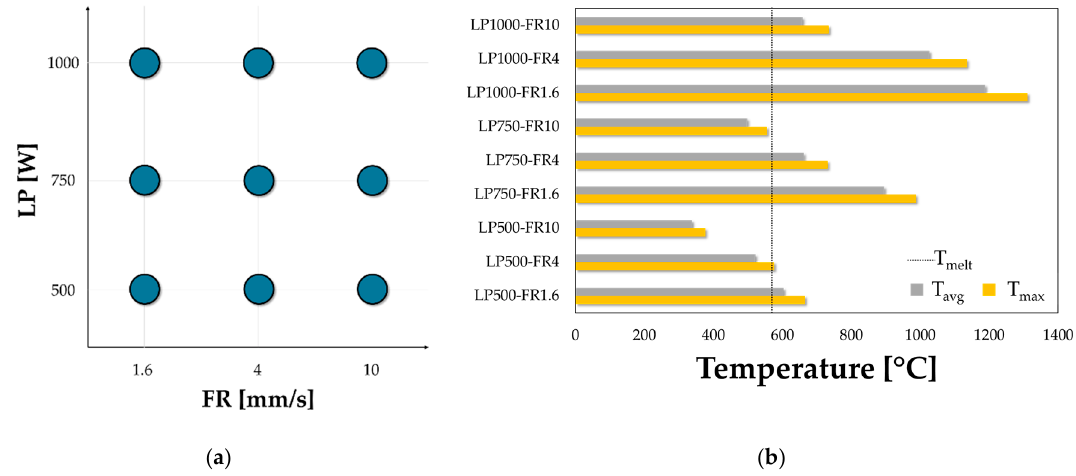
Figure 14. LHT numerical simulation (FR = 4 mm/s): temperature distribution after ( a ) half and ( b ) at the end of the heating.